Question: Express in one sentence what the figure is showing.
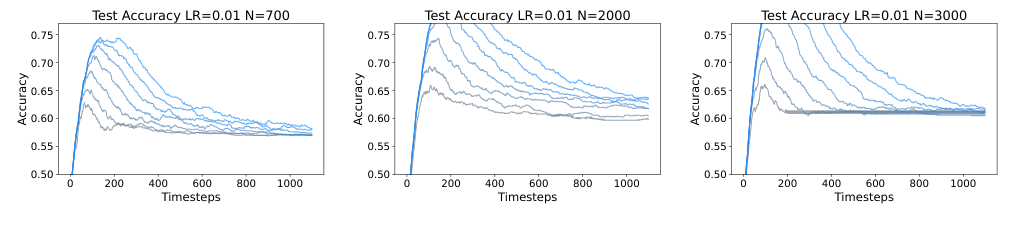
Answer: Behavior with number of training examples for linear model/toy Gaussian data with 40% label noise. Linear models trained with different subsets of the toy Gaussian data observe different levels of benefit with SAM. ρ is scaled between 0.03 and 0.18, bluer curves signifying higher ρ. The data is 1000 dimensions. Note that performance improves with SAM even in underparametrized regimes.